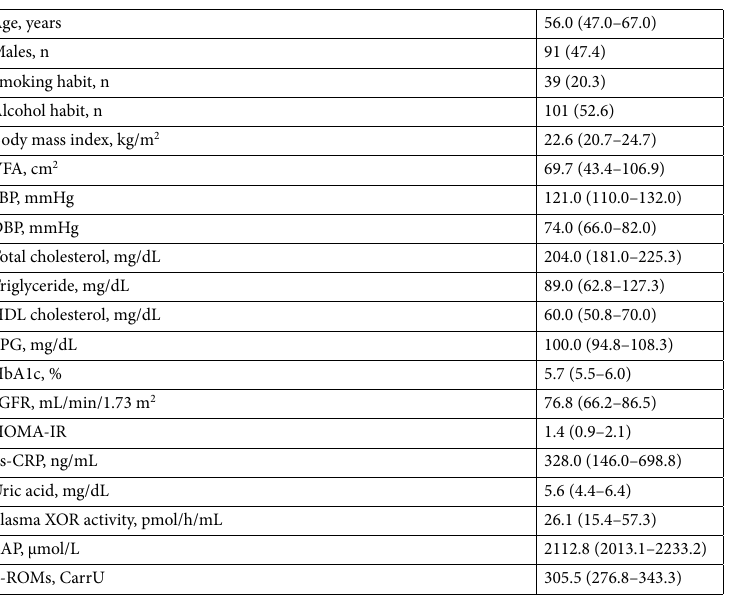
Table 1. Clinical characteristics of subjects (n = 192). Data are expressed as the median (inter-quartile range) or number (%). VFA visceral fat area, SBP systolic blood pressure, DBP diastolic blood pressure, HDL high- density lipoprotein, FPG fasting plasma glucose, HbA1c glycated hemoglobin, eGFR estimated glomerular filtration rate, HOMA-IR homeostatic model assessment of insulin resistance, hs-CRP high-sensitivity C-reactive protein, XOR xanthine oxidoreductase, BAP biological antioxidant potential, d-ROMs derivative of reactive oxygen